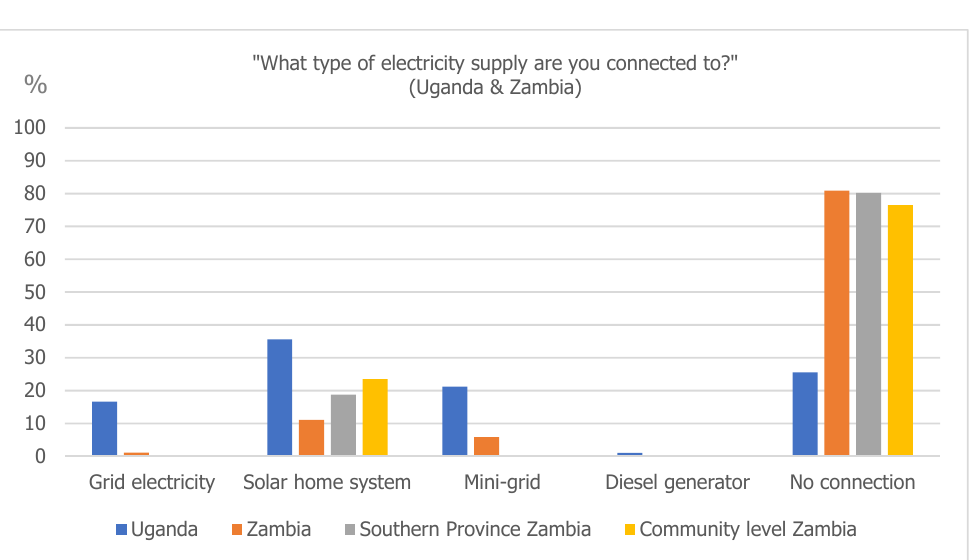
Figure 4. Type of energy supply, Uganda and Zambia (Responses in %; N = 1037).